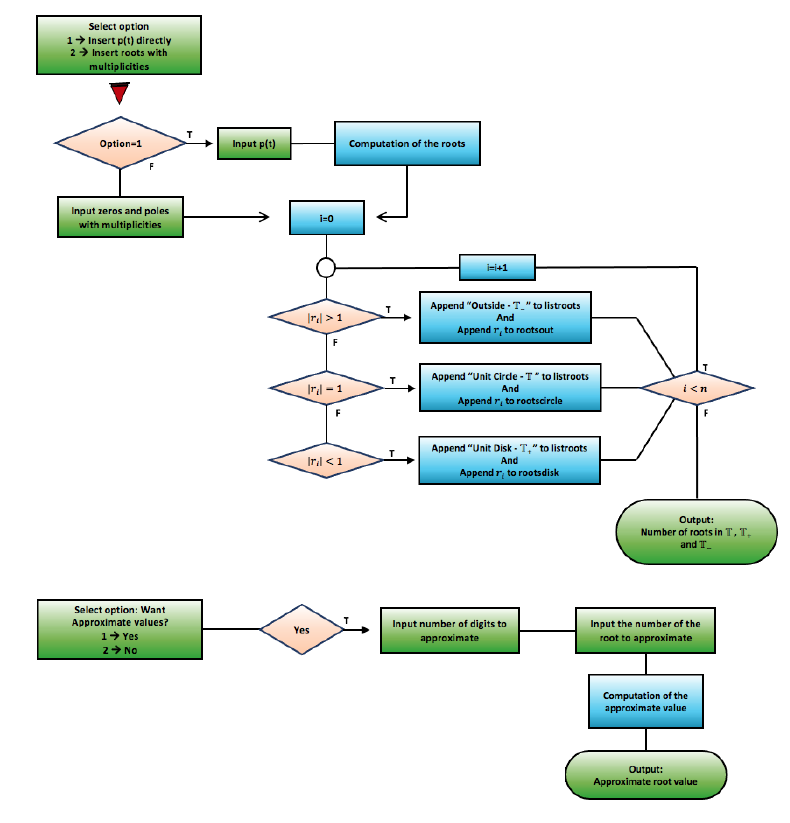
Figure 31. Flowchart of the [ARoots]